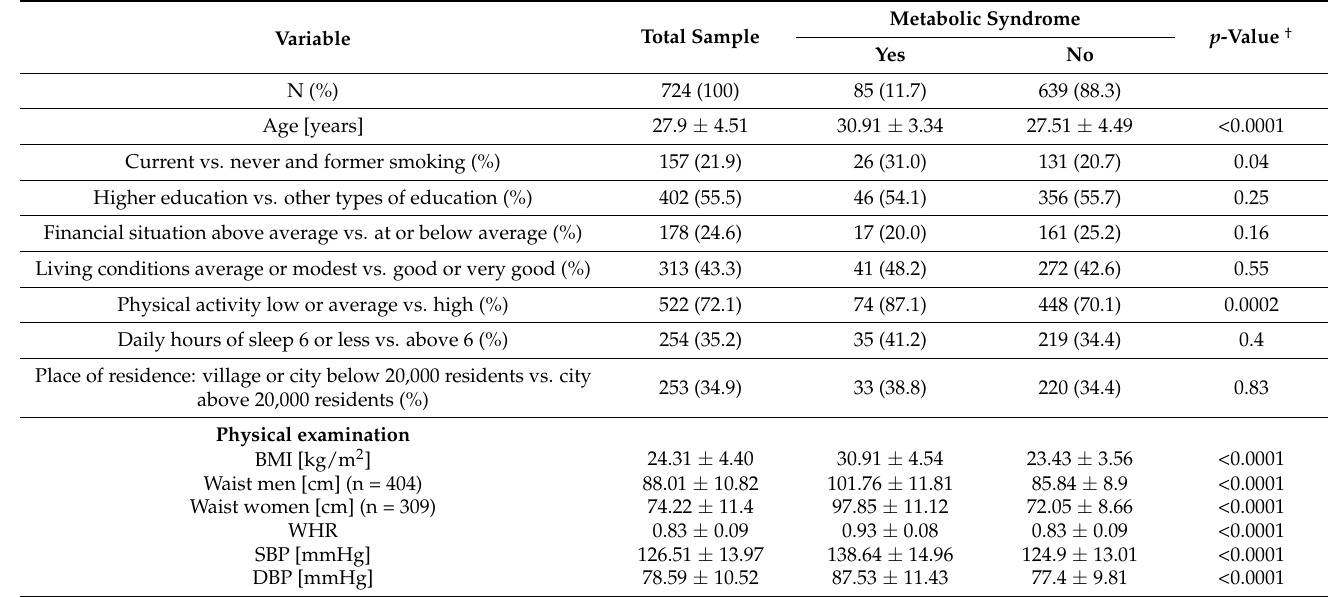
Table 1. The comparison of clinical and sociodemographic findings between young adult patients with and without MS.